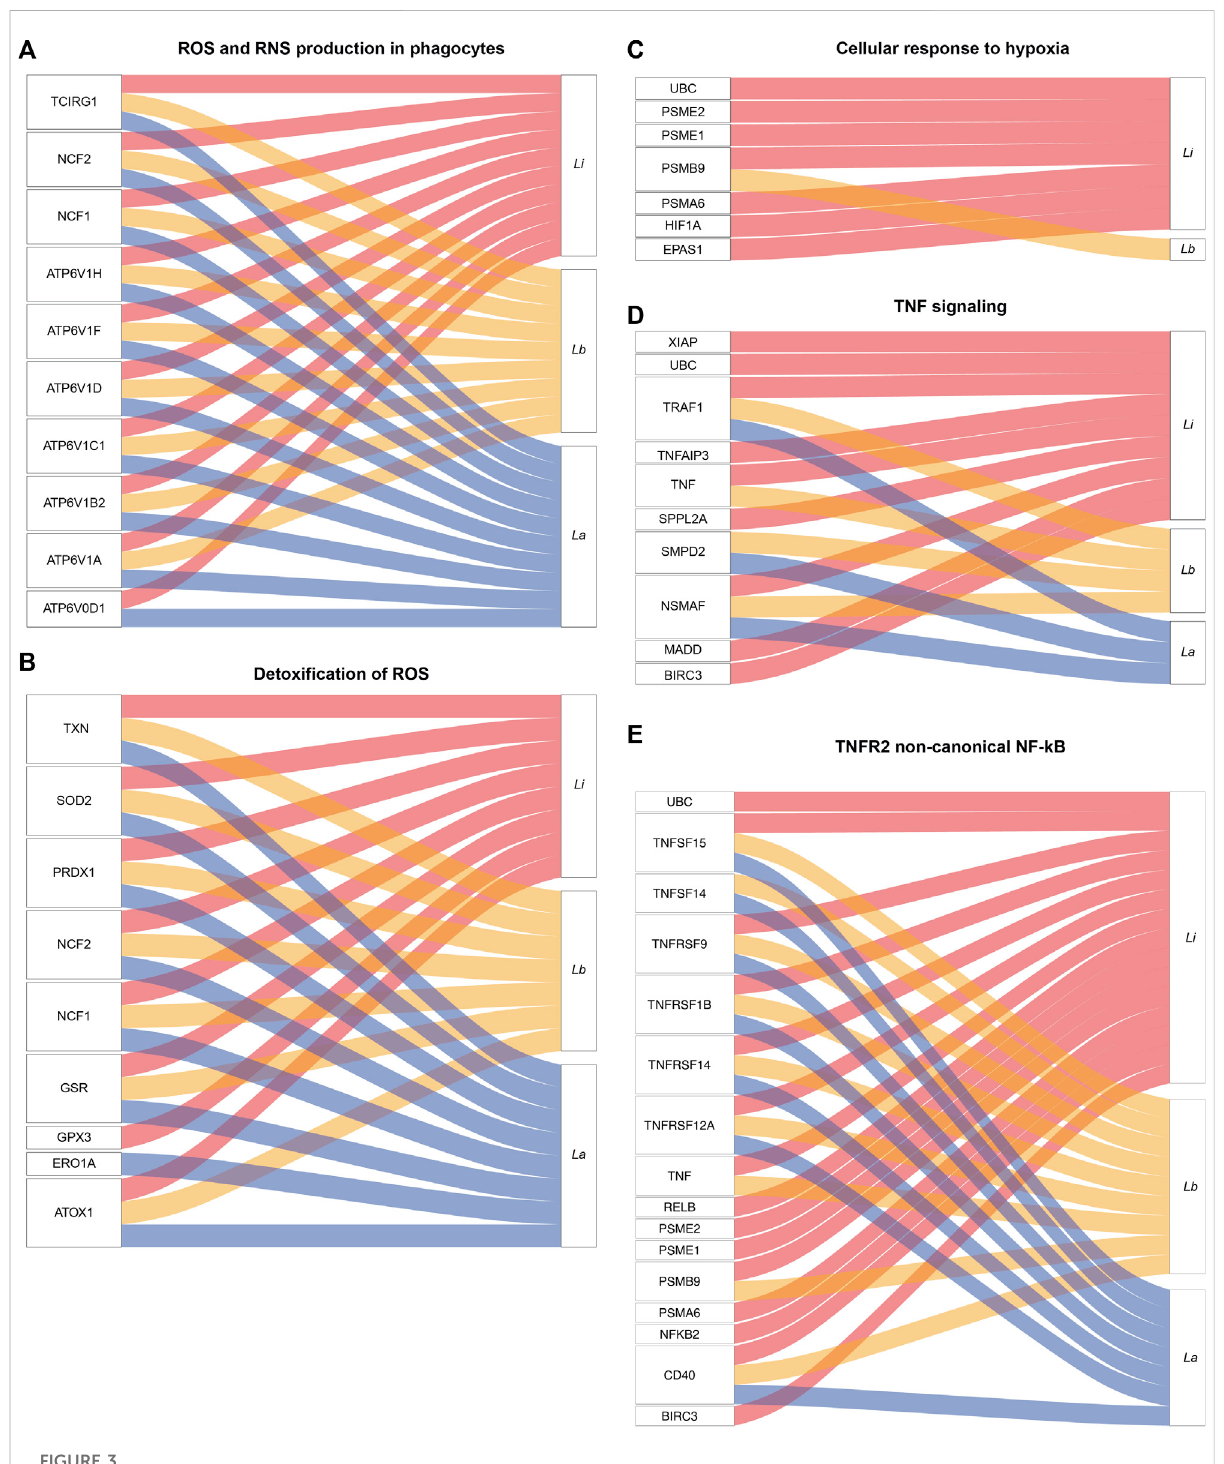
FIGURE 3 Alluvial plots representing enriched pathways and their related protein coding genes modulated in Leishmania-infected THP-1 macrophages. The alluvial plots show the signi fi cantly differentially expressed mRNAs in La (blue lines), Lb (yellow lines) and Li (red lines)-infected macrophages for 5 enriched pathways (A) Reactive oxygen species (ROS) and reactive nitrogen species (RNS) production in phagocytes (B) Detoxi fi cation of ROS (C) Cellular response to hypoxia (D) Tumor necrosis factor (TNF) signaling and (E) TNF receptor 2 (TNFR2) non-canonical nuclear factor kappa B (NF- κ